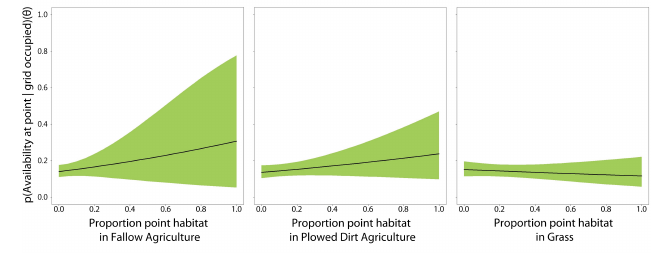
Table 2 . Top model set, and the null model for comparison (in bold), for multiscale occupancy analysis predicting the occupancy Fig. 4 . Model averaged predictions generated from multiscale of transects within Idaho by Short-eared Owls ( Asio flammeus ) occupancy top model set for the effect size of the proportion of during the 2015 breeding season. k is the number of parameters area within 400 m of surveyed point in (a) fallow agriculture; (b) in the model, AICc is Akaike’s Information Criterion adjusted plowed dirt agriculture; and (c) grass, influencing the availability for small sample size, Δ AICc is the difference in AICc values of at least one Short-eared Owl ( Asio flammeus ) at the point to be between individual models and the top model, and w is the model i sampled given that the transect was occupied by at least one weight. We only presented models where Δ AICc ≤ 2.00, the set Short-eared Owl during the 2015 breeding season. Black line = used to generate model averaged predictions, and the null model model prediction; green area = 95% confidence for comparison.